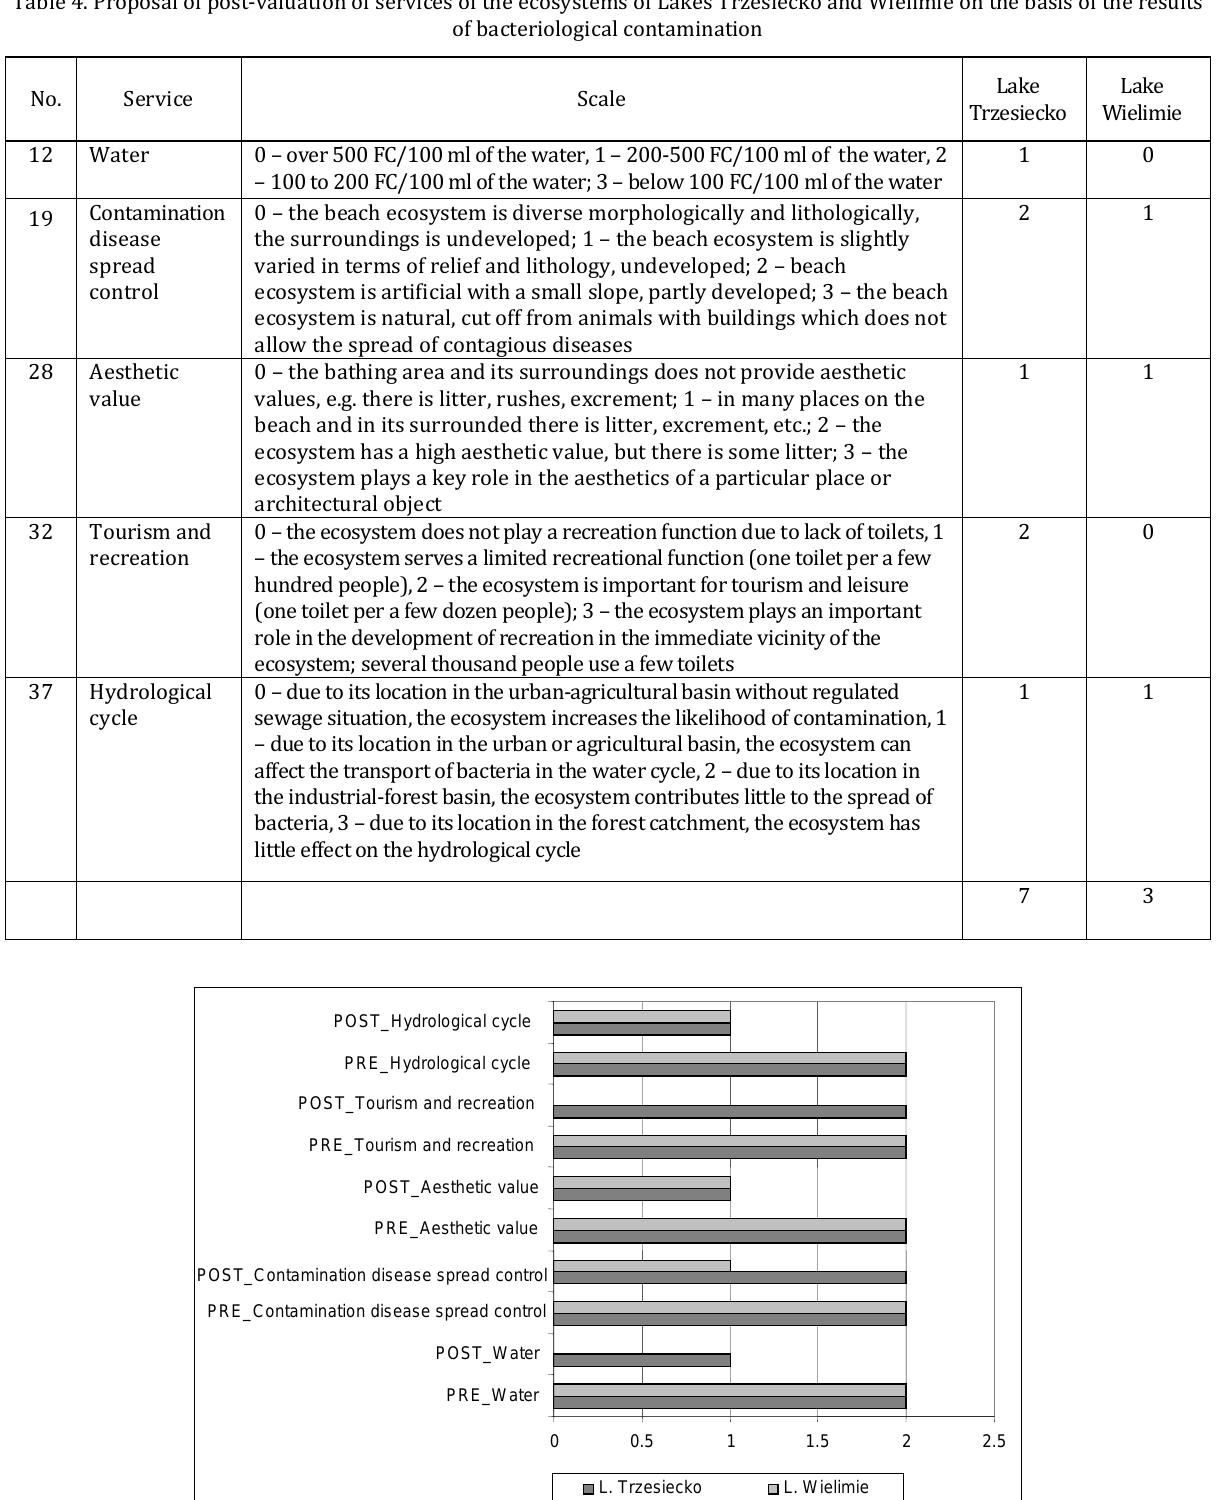
Fig. 4. Pre-valuation and post-valuation of services of the ecosystems of Lakes Trzesiecko and Wielimie on the basis of the results of bacteriological